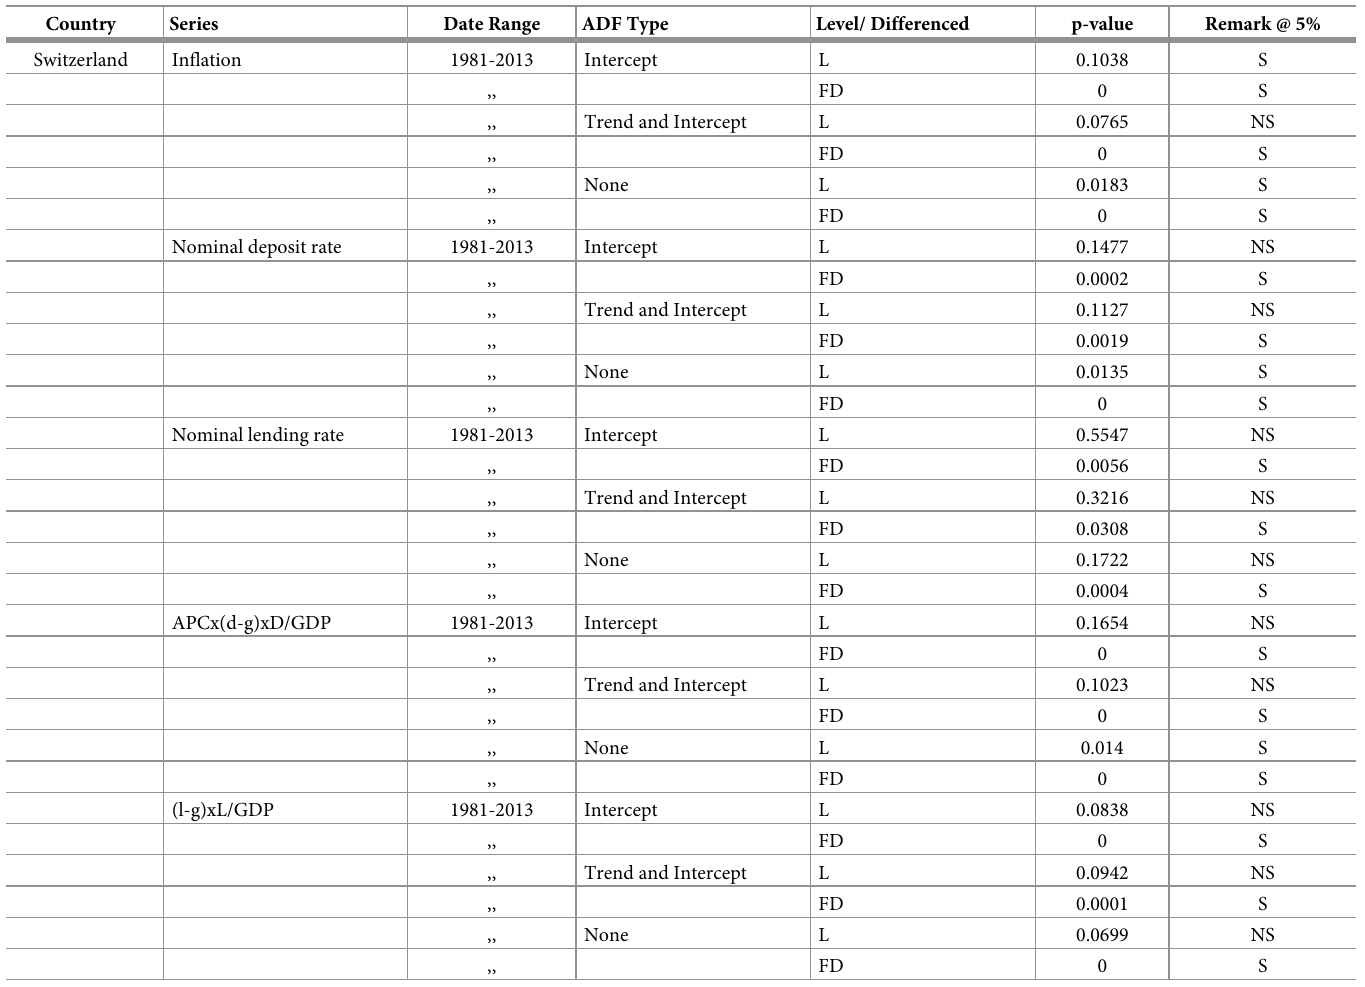
Table 4. ADF Unit Root